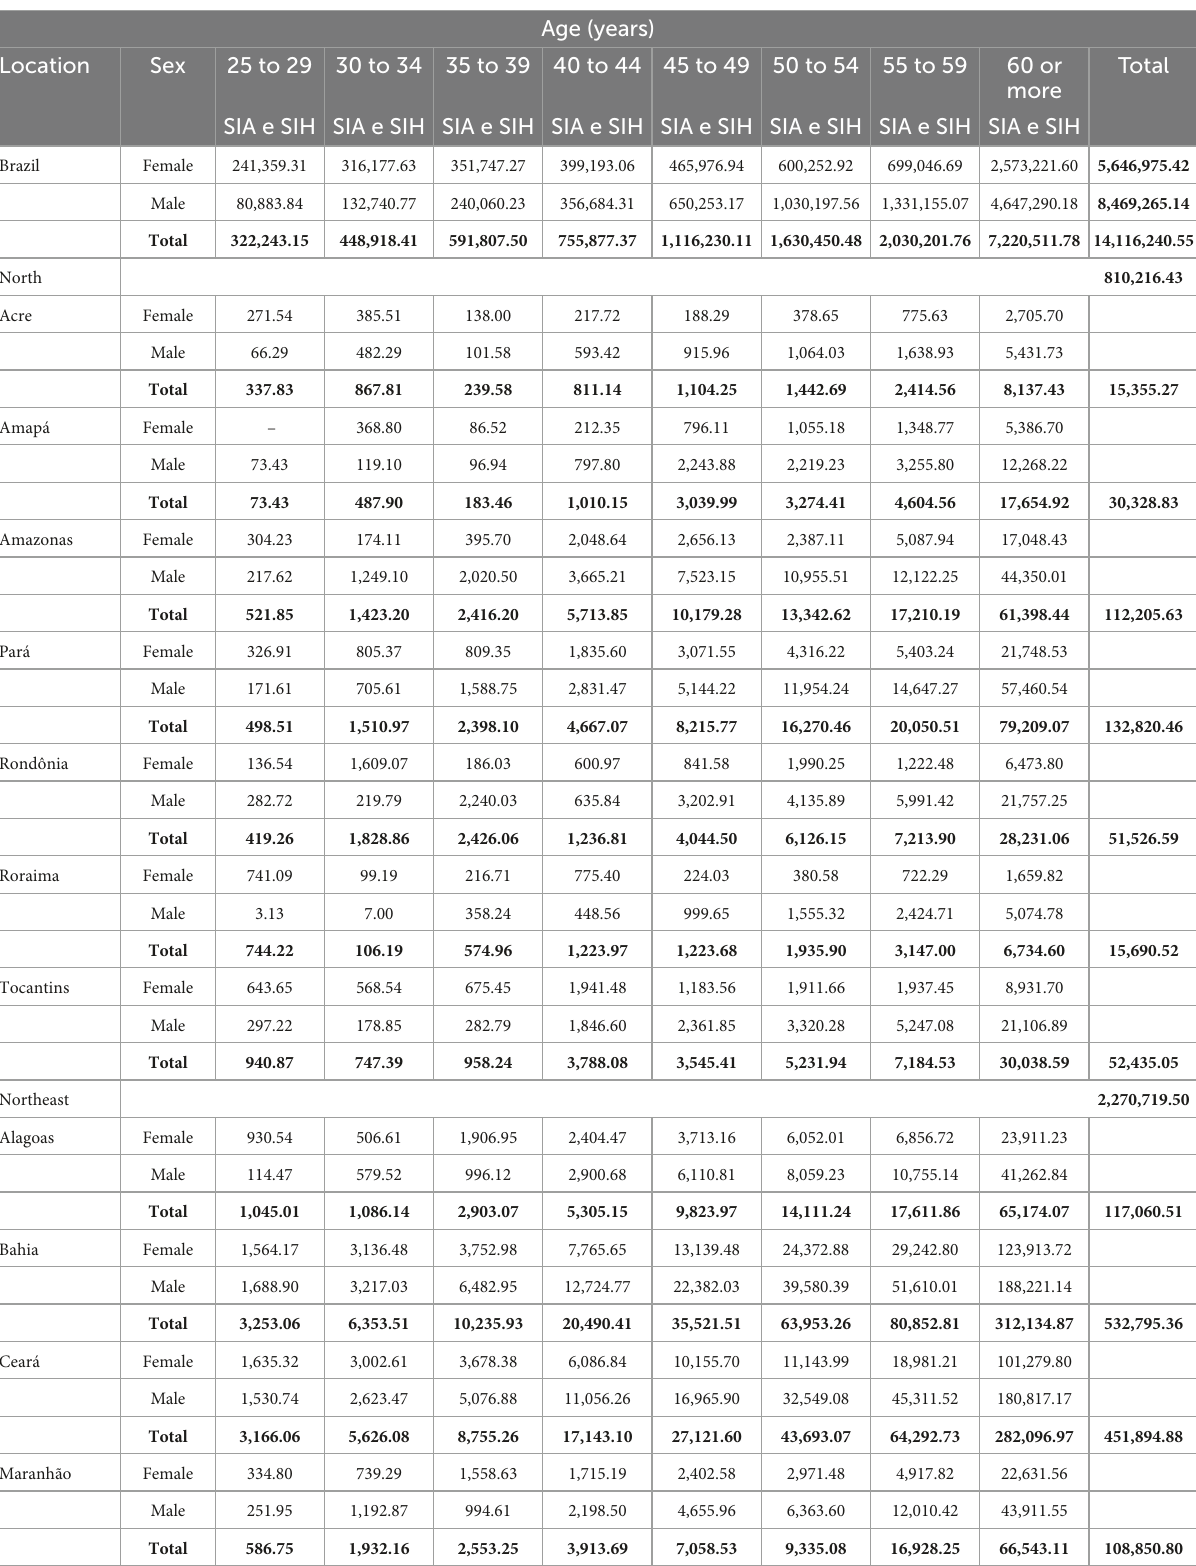
TABLE 1 Financial costs in the treatment of NCDs attributed in the consumption of SSBs, international dollars (US$), in the year 2019, by sex, age group, regions and Brazilian federative units, and outpatient information system (SIA) and hospital information system (SIH), according to Global Burden of Disease (GBD)